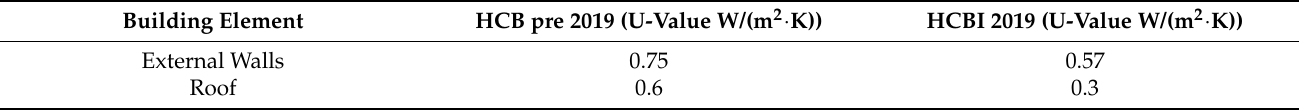
Table 2. Thermal transmittance (U-value) requirements for external walls and roofs in Bahrain. Building